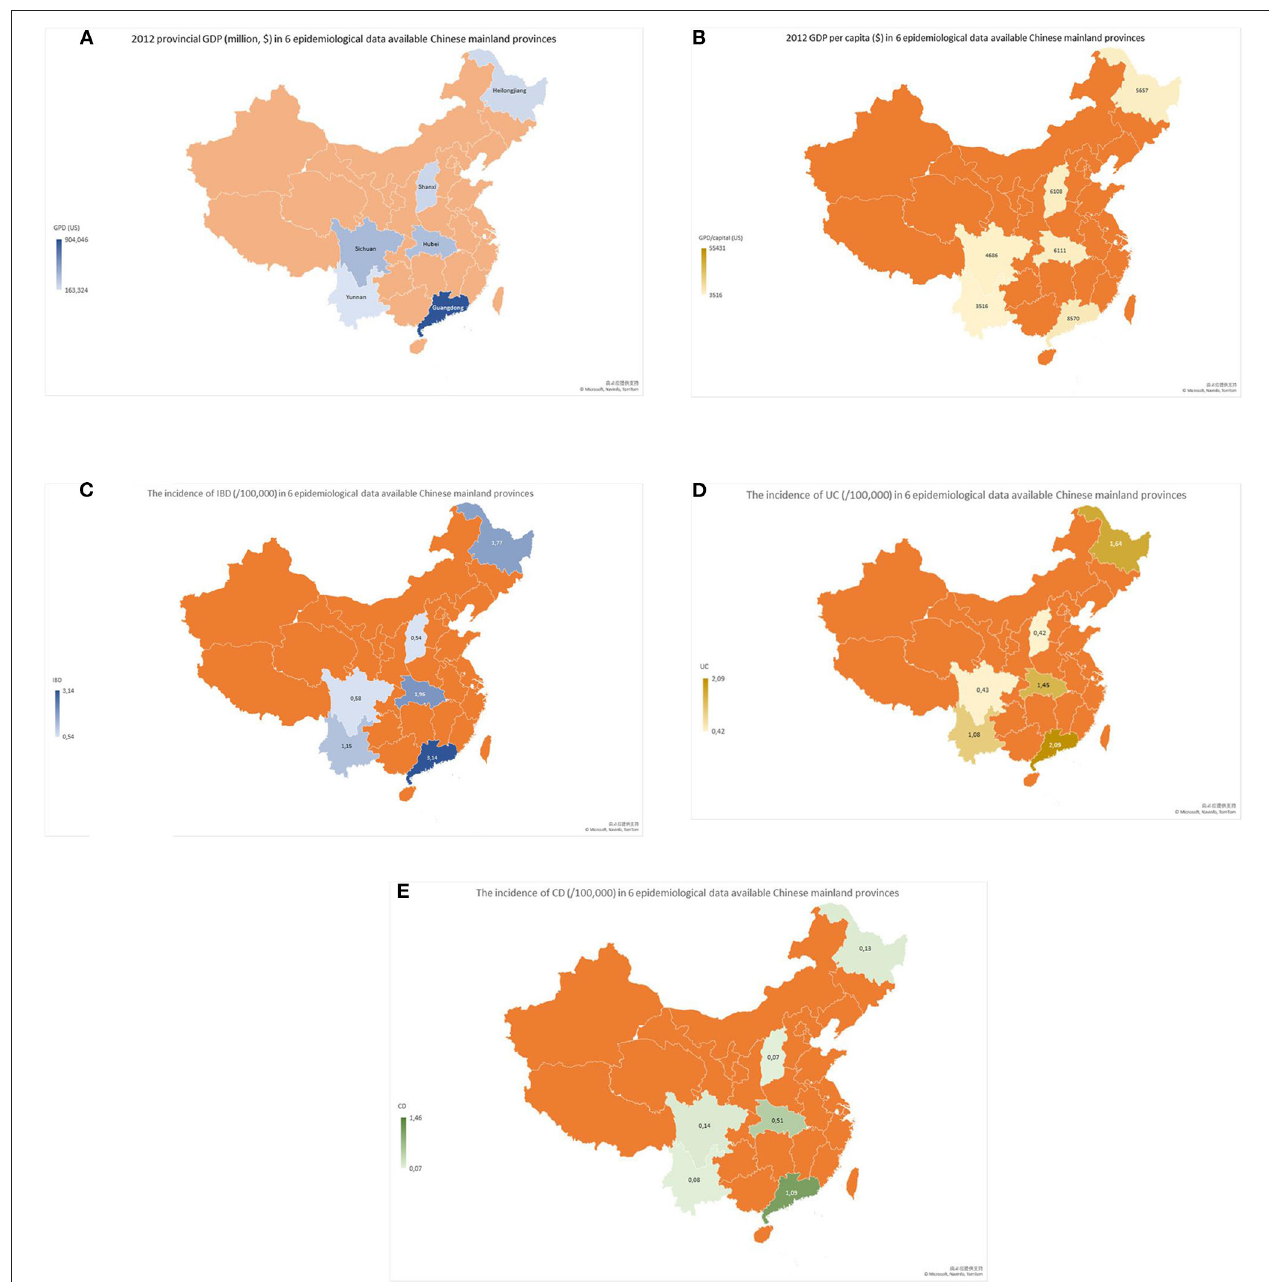
FIGURE 1 | Maps of GDP (million $), GDP per capita ($), and IBD, UC and CD incidences (/1,000,000) in six Chinese mainland provinces with different levels of industrialization and available epidemiological data. The maps showed that provincial GDP (A) and GDP per capita (B) in Guangdong Province (southern China) were obviously higher than those in Sichuan and Yunnan Provinces (southwestern China). Interestingly, incidences of IBD (C) , UC (D) and CD (E) were also higher in Guangdong Province than in Sichuan and Yunnan Provinces. In addition, incidences of IBD (C) , UC (D) and CD (E) in Hubei Province (central China) and Heilongjiang Province (northern China) with a middle level of GDP per capita developed industrialization were higher than those in Sichuan and Yunnan Provinces (both in southwestern China).